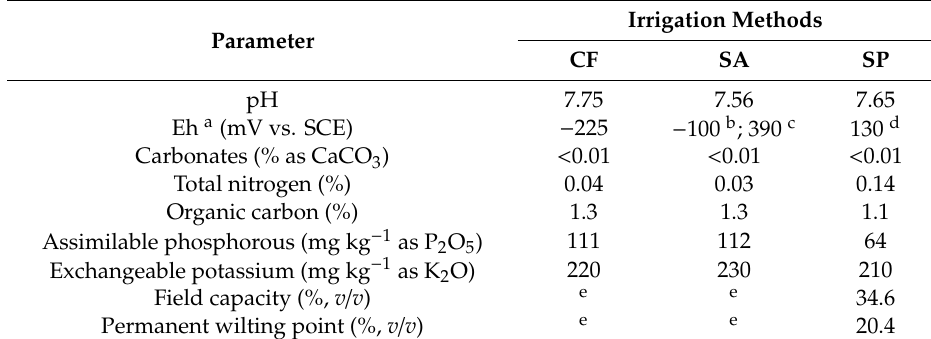
Table 3. Chemical and hydrological parameters of the soils (layer depth: 0–20 cm, particle size: < 2 mm) involved in the experiment. CF, continuous flooding irrigation, SA, saturation irrigation, SP, sprinkler